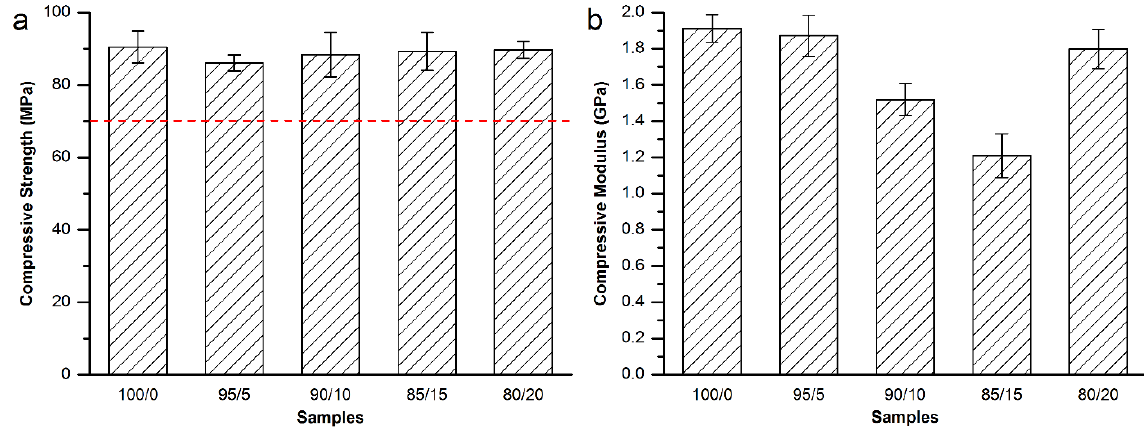
Figure 2. ( a ) Compressive strength and ( b ) compressive modulus of the MC modified Osteopal ® V bone